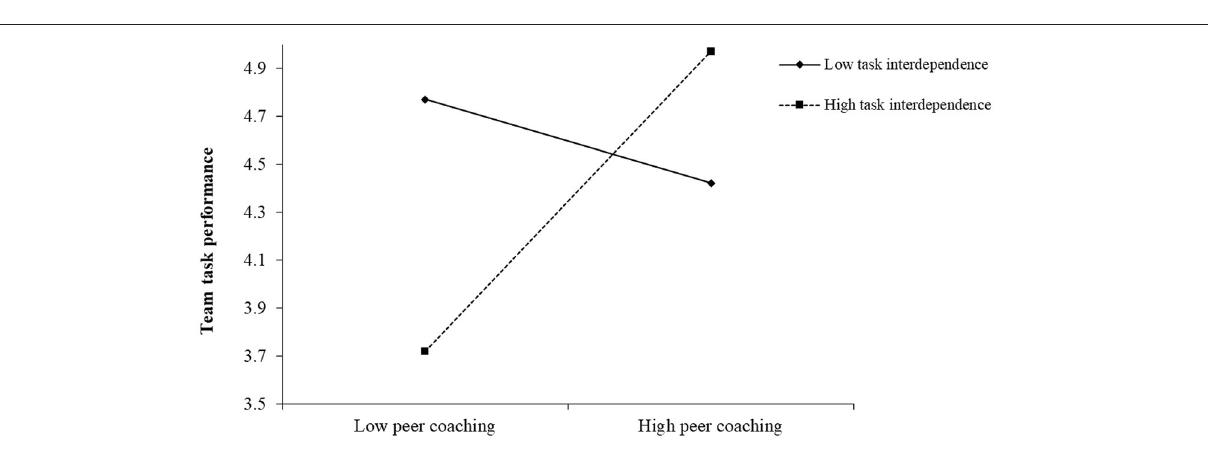
FIGURE 3 | Interactive effect of peer coaching and team task interdependence on team performance.